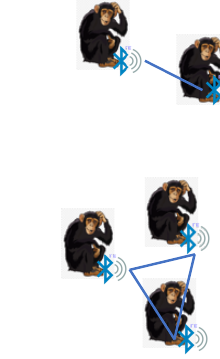
Figure 2. Proximity-based mesh